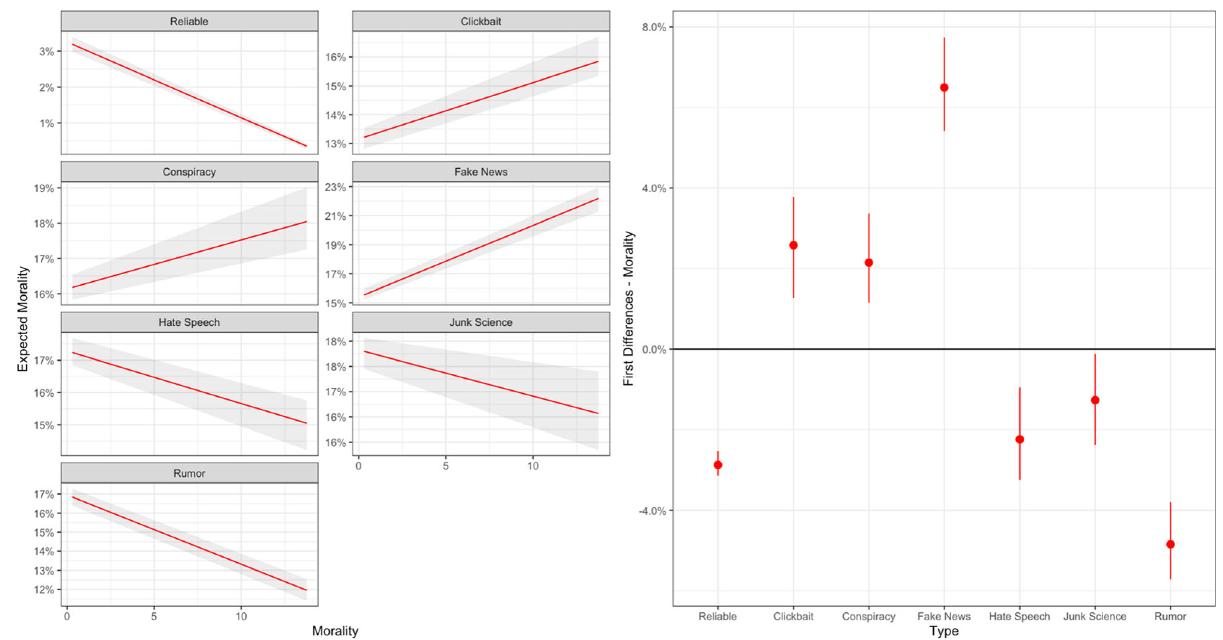
Fig. 8 First differences of the multinominal logit model −